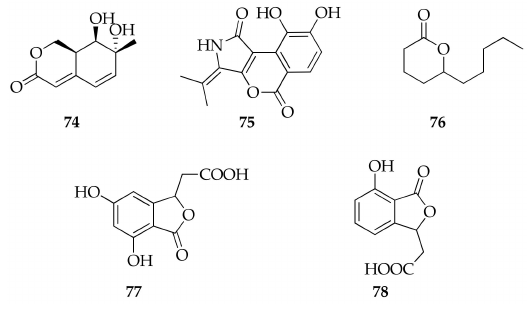
Figure 17. Structures of